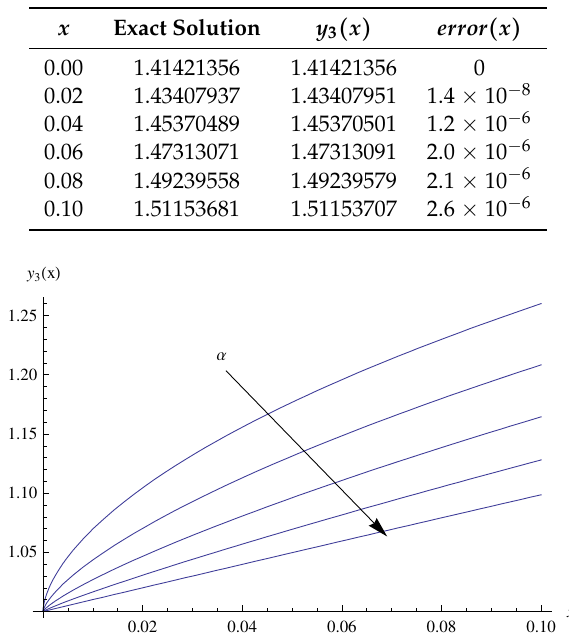
Figure 3. The approximate solution for α = 0.6, 0.7, 0.8, 0.9, 1.